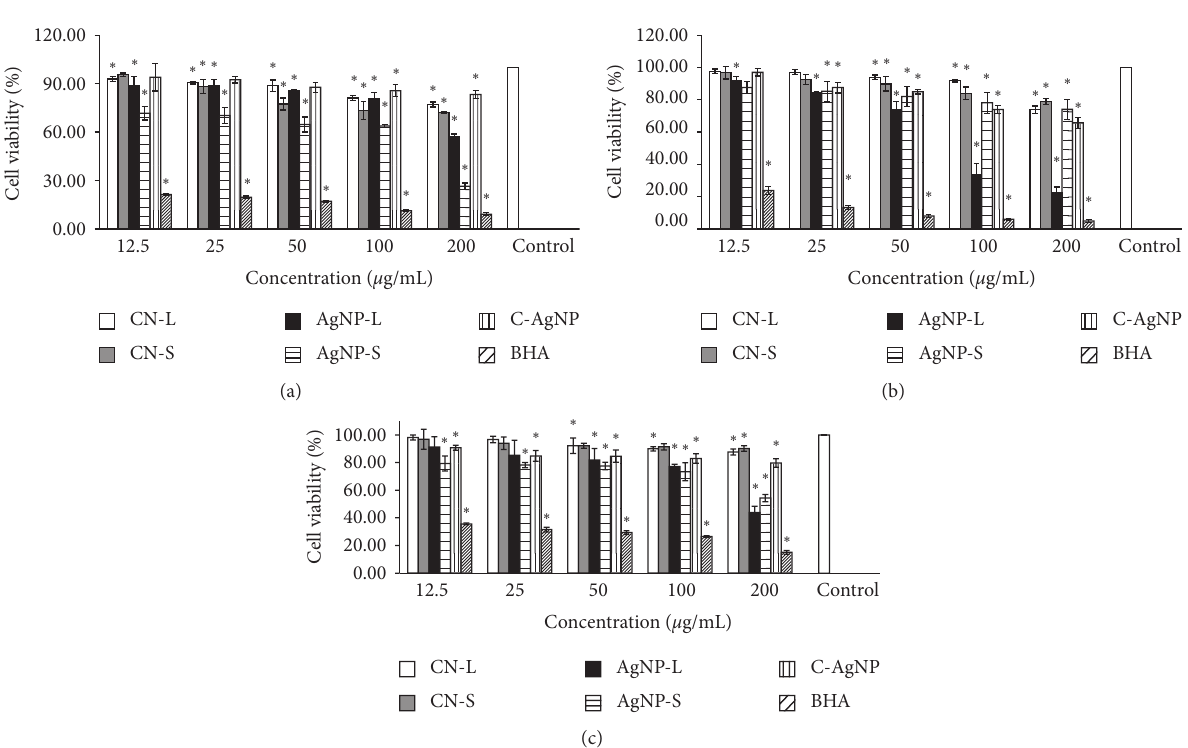
Figure 2: Cell viability after 72h at different concentrations (12.5–200 μ g/mL) on (a) MCF-7, (b) HT-29, and (c) HeLa. The ∗ symbol ( p < 0.05) represents the significant difference between the sample and control (untreated cells) (mean ± SD, n �